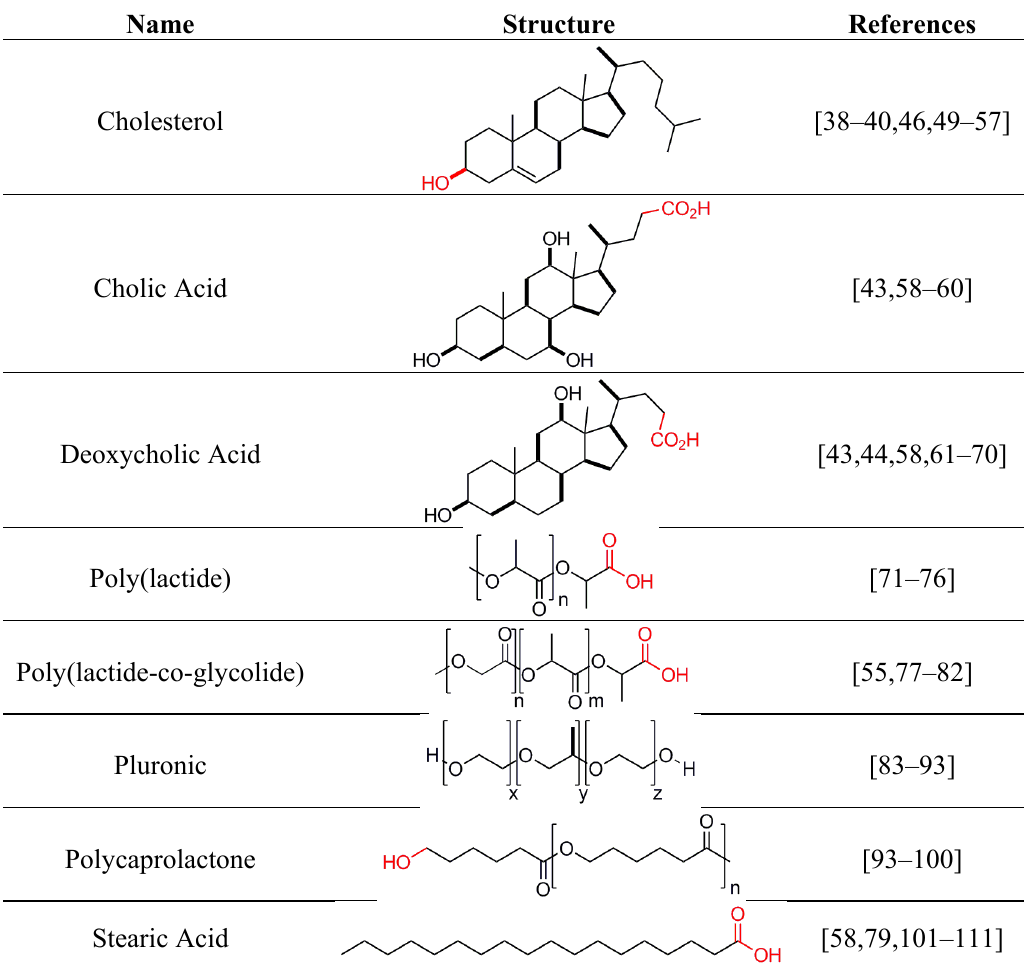
Table 1. Names and structures of hydrophobic moieties used in the development of polysaccharide-based micelle drug delivery systems. Functional groups used for grafting onto polysaccharides are highlighted in